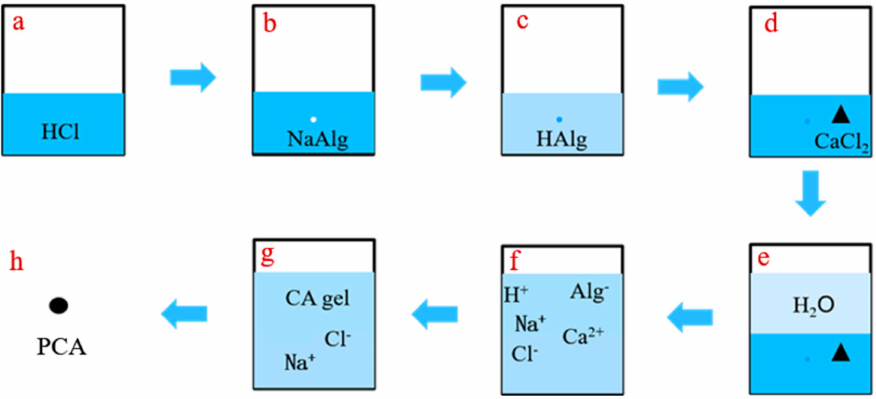
Figure 2. Ion changes in the preparation process of